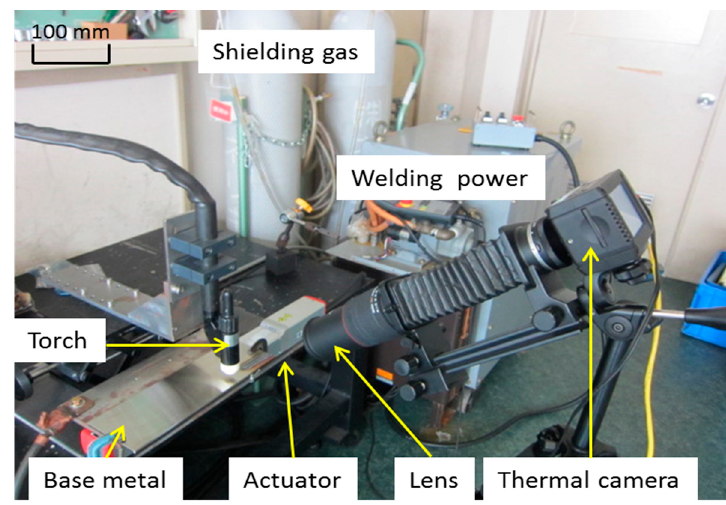
Appl. Sci. 2020 , 10 , x; doi: FOR PEER REVIEW Figure 4. Experimental setup of temperature distribution measurement. Figure 4. Experimental setup of temperature distribution measurement.